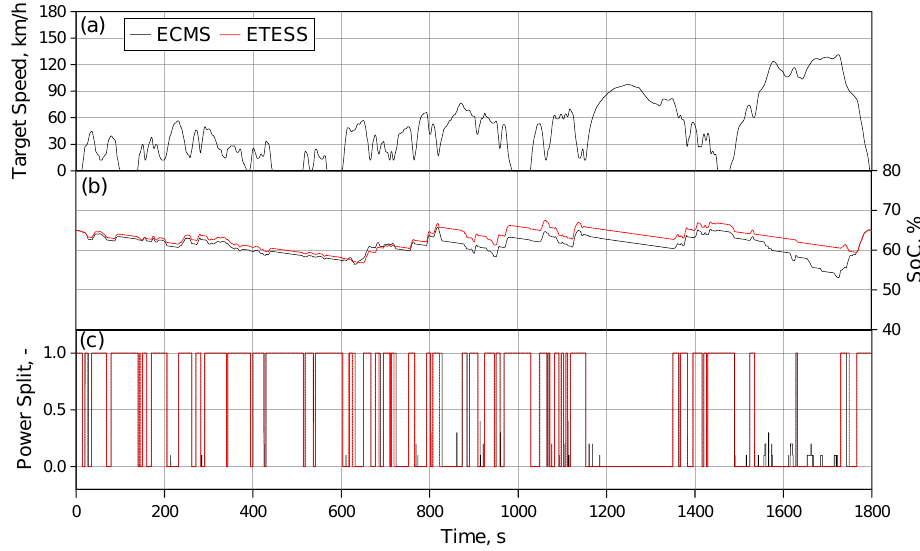
Figure 6. ( a ) Target speed (km/h). ( b ) Battery SoC (%) between ETESS and ECMS. ( c ) Power split between ETESS and